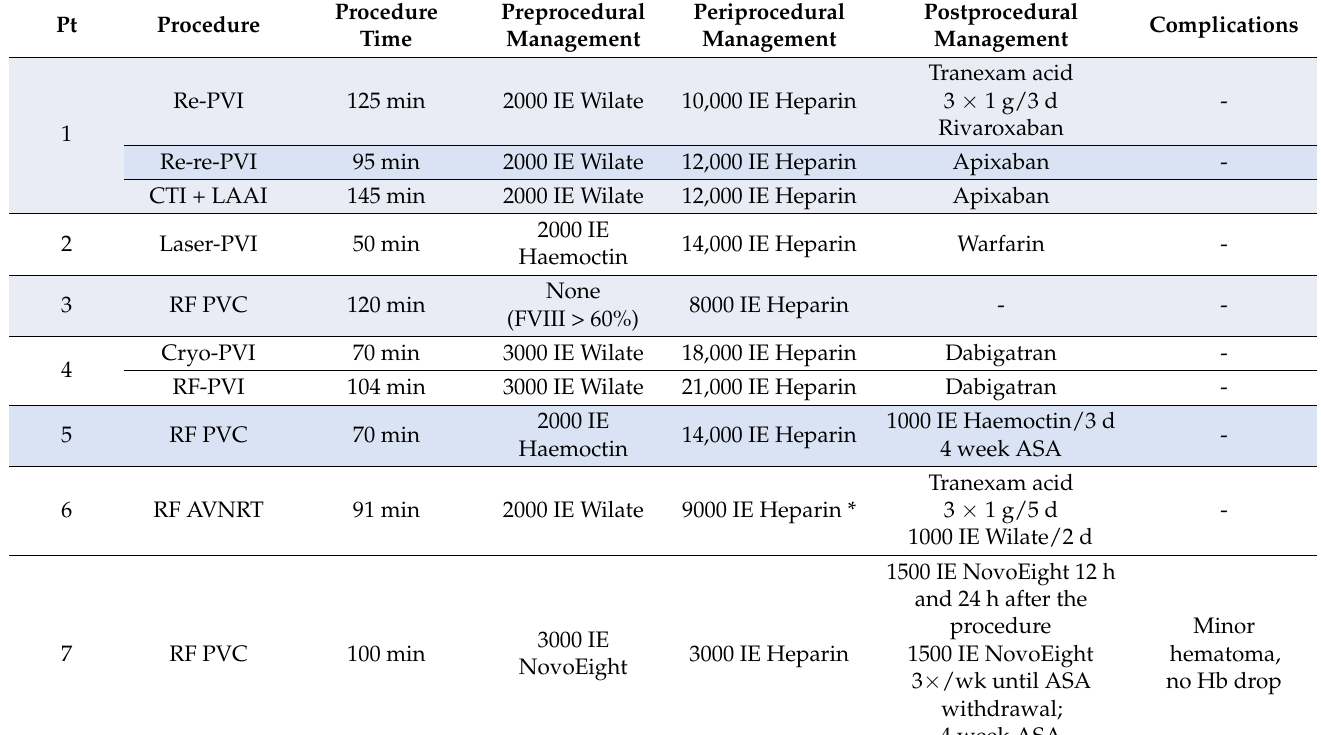
Table 2. Pre-, peri- and postprocedural anticoagulation